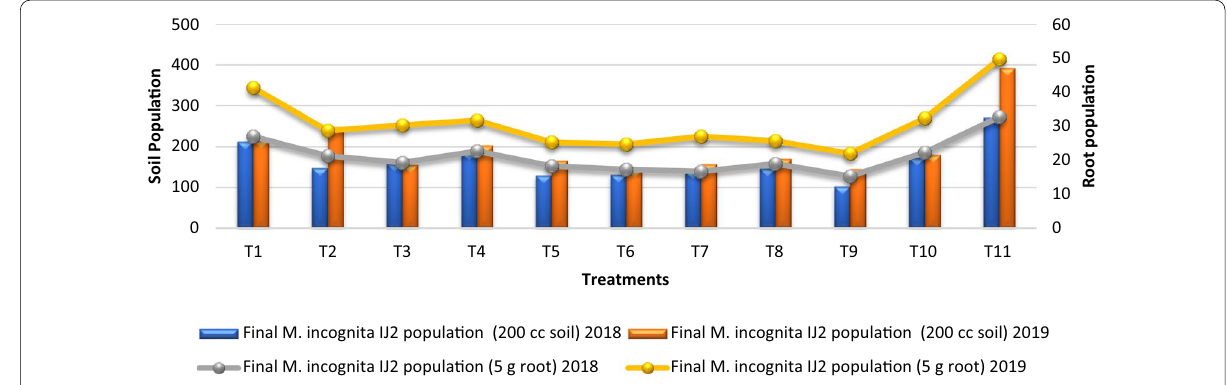
Fig. 3 Trend of root knot nematode population in roots and soil during 2018 and 2019